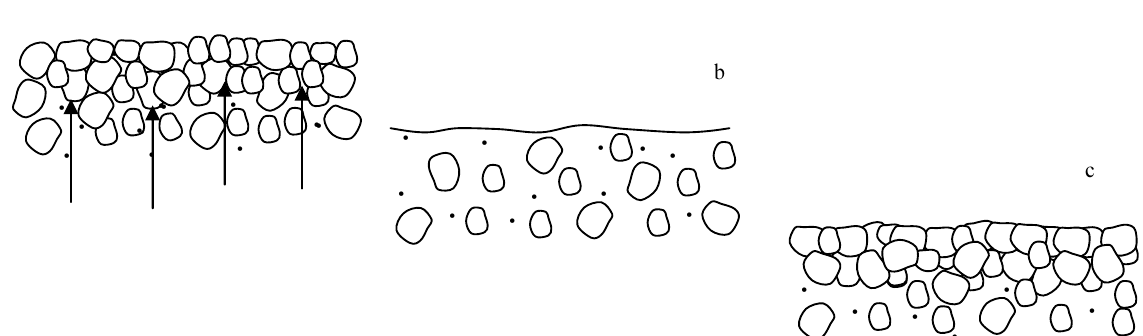
Fig. 2 . Stages of riverbed self-lining: a – uplift forces destroy and remove protecting layer; b – scour of small ground particles continues; c – new protecting layer